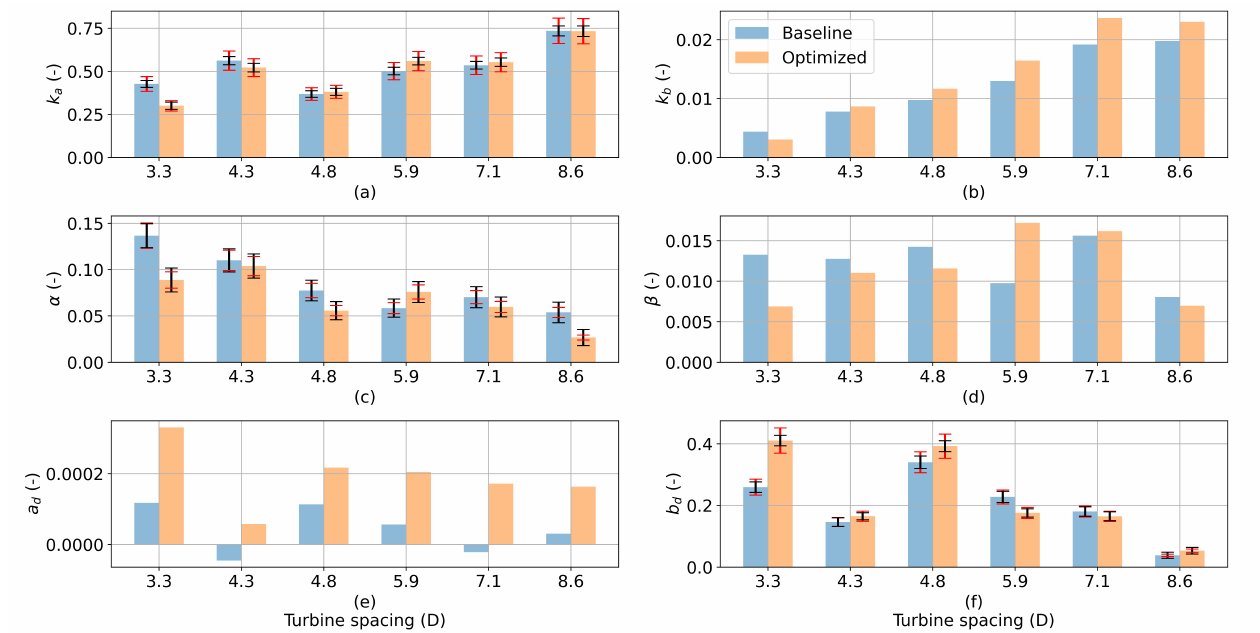
Figure 5. The Sobol sensitivity indices per turbine spacing for both the baseline and optimized case. The 95% confidence interval error bar ( black ) and the 10% deviation ( red ) are shown for the most sensitive parameters. ( a ) corresponds to k a ( b ) to k b ( c ) to α ( d ) to β ( e ) to a d ( f ) to b d